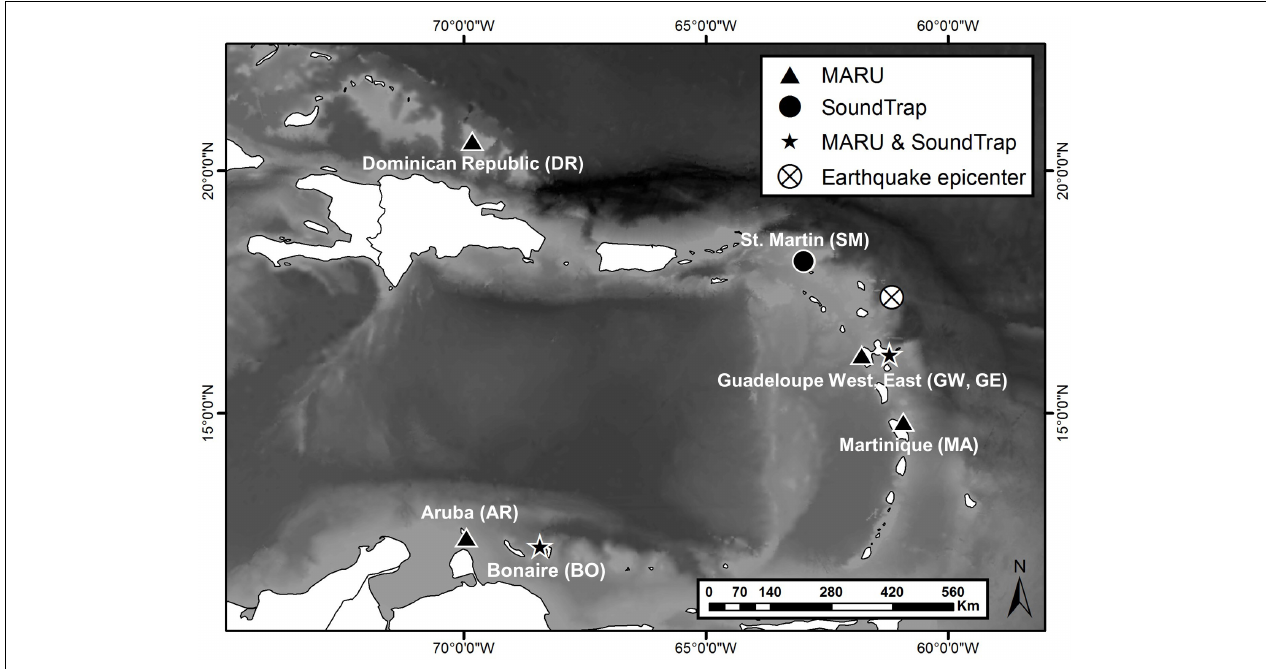
FIGURE 1 | A map of the seven passive acoustic recording sites and equipment deployed in the Caribbean, December 2016 through June 2017. The recorder type, Marine Acoustic Recording unit (MARU) or SoundTrap acoustic recorder are marked as well. X marks the epicenter for a large earthquake that occurred on 17 April 2017 at 17.450 N 61.142 W.